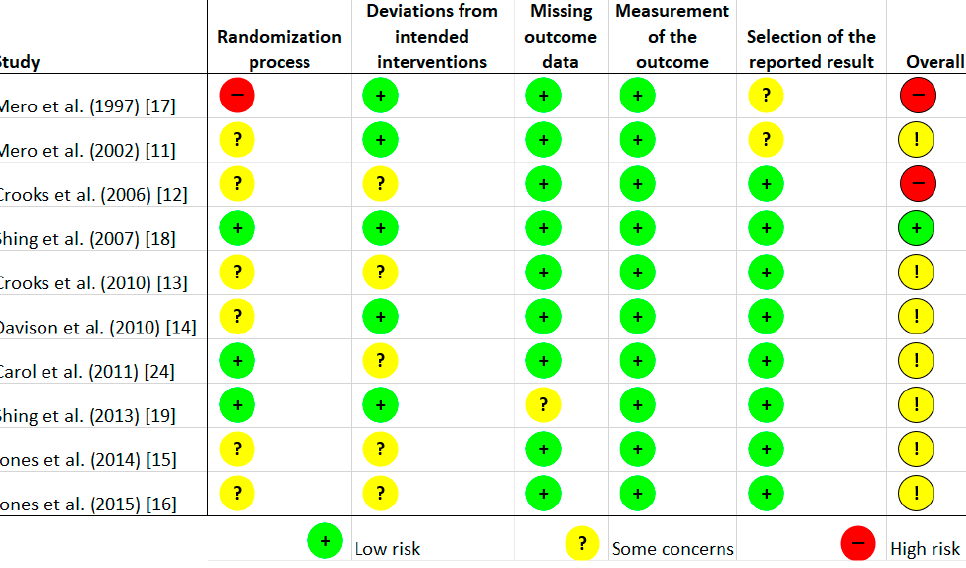
Figure 1. Risk of bias of included studies.